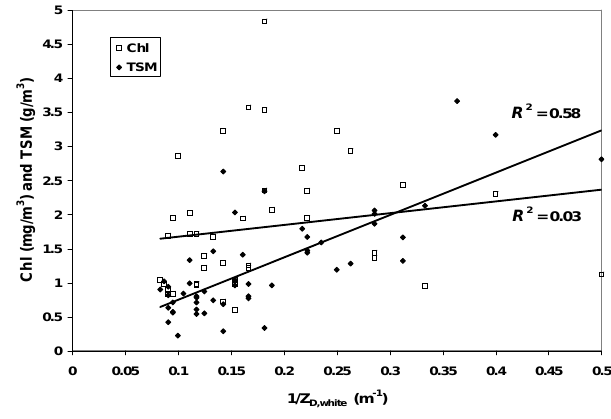
R 2 = 0.58 R 2 = 0.03